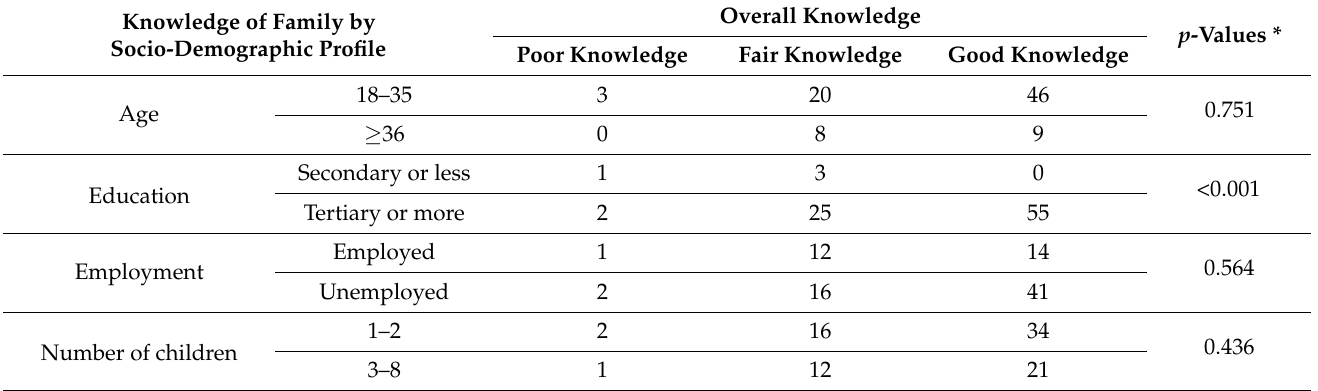
Table 3. Knowledge of participants by sociodemographic profile % in rows ( n =